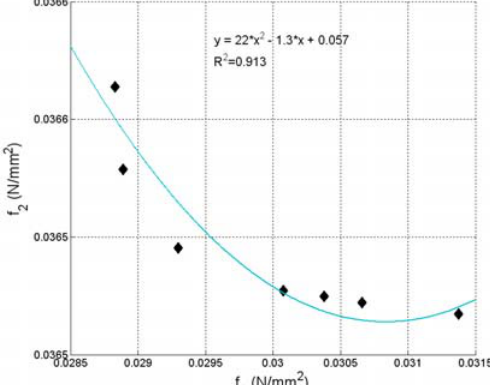
Fig. 7. The Pareto front of non-dominated